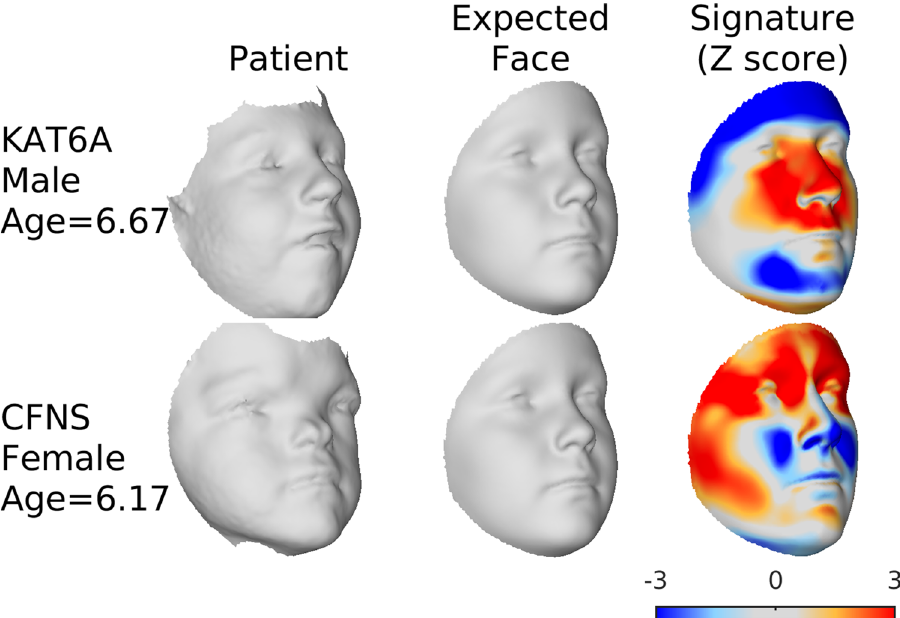
Figure 6. Assessing individual patients. The first column plots the age and sex-specific expected face for the age and sex of the patient. The second plots the 3D image of the patient morph. The third plots the facial signature of the patient morph along the direction perpendicular to the expected face. Each point is colored according to the patient morph’s individual z-score. Orange and red indicates the region of the face is displaced outwardly, relative to the expected facial shape, light and dark blue indicate the point is displaced inwardly. Dark red and dark blue indicate z scores outside of the range ± 2. This figure was generated in MATLAB 2021a (https:// www. mathw orks. com/).